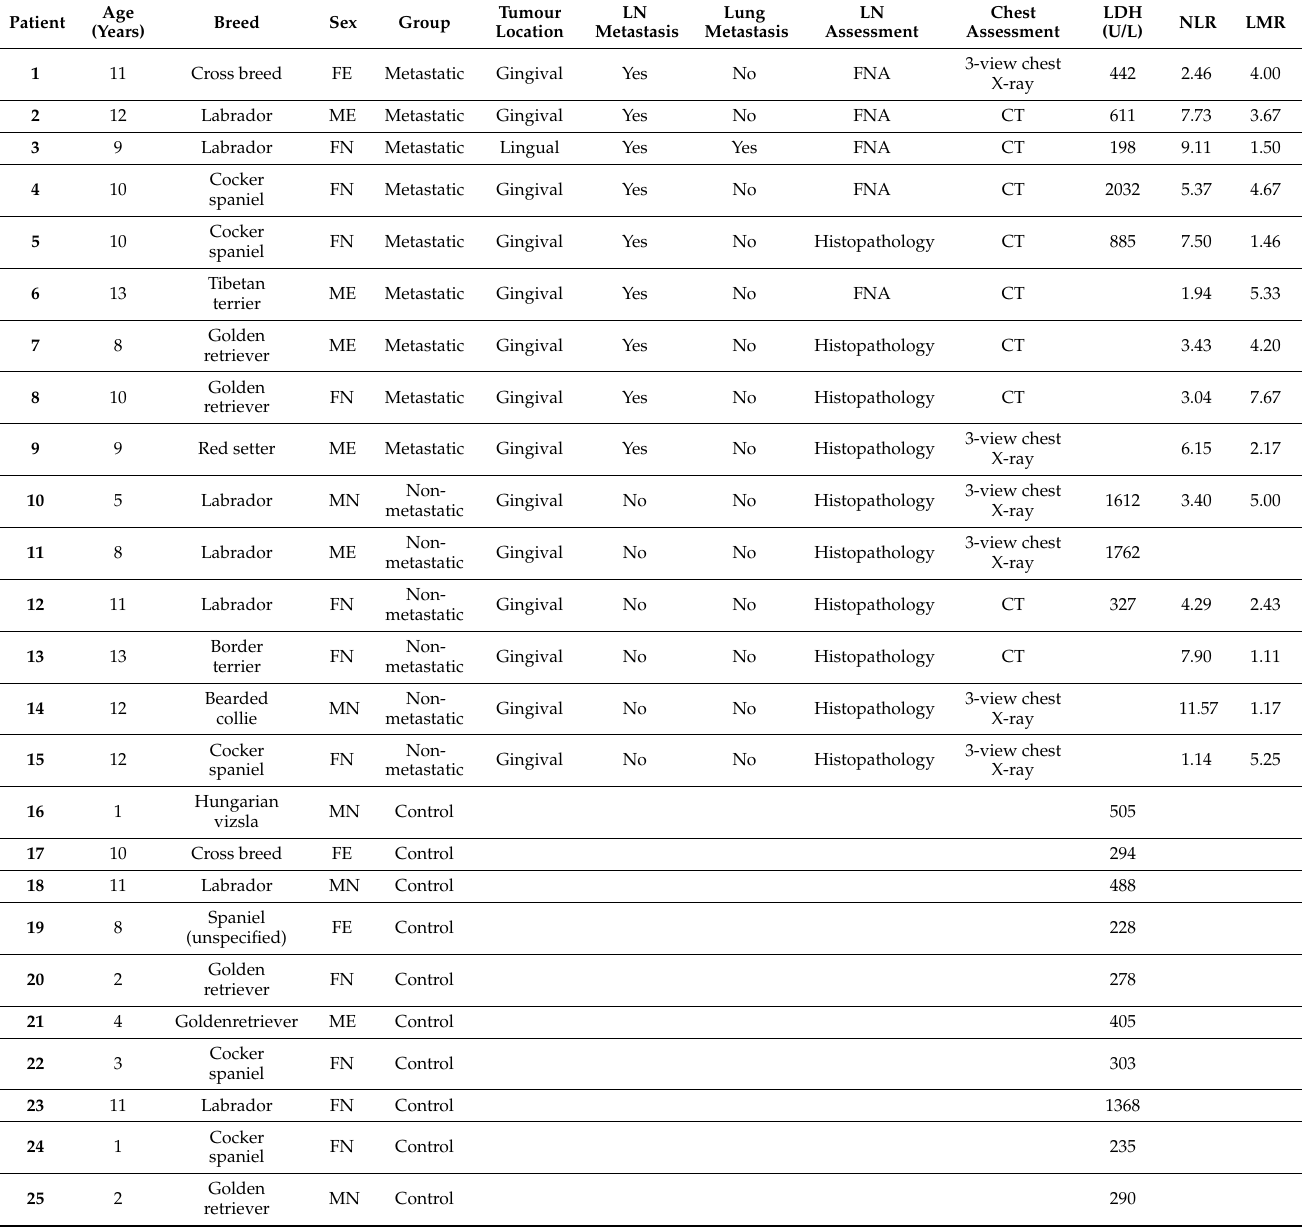
Table 2. Patient population